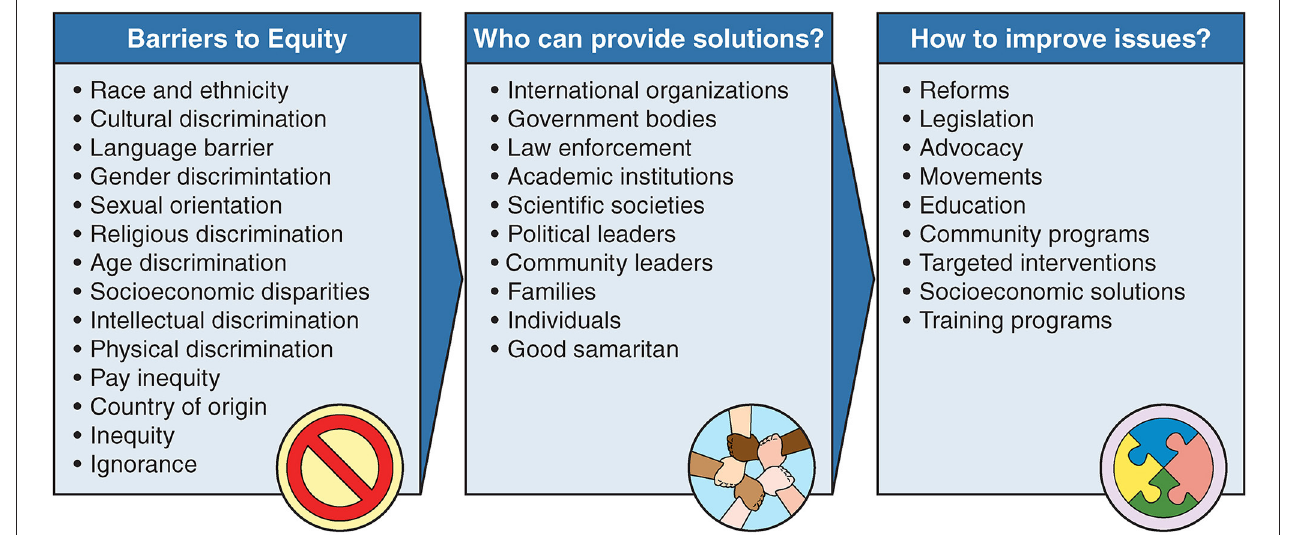
FIGURE 1 | Barriers to equity: who can provide solutions and how?